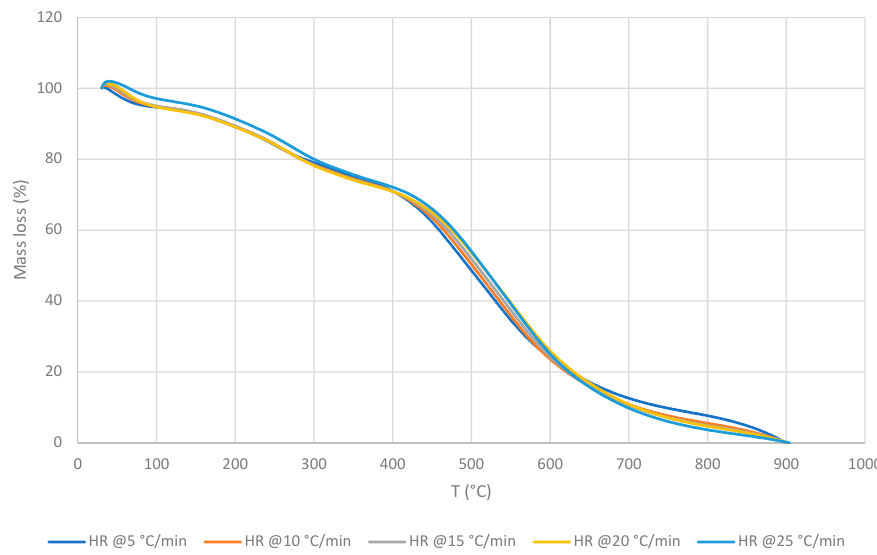
Figure 6. TGA traces of the outer non-homogenous mesh (ONHM) layer at different HRs.